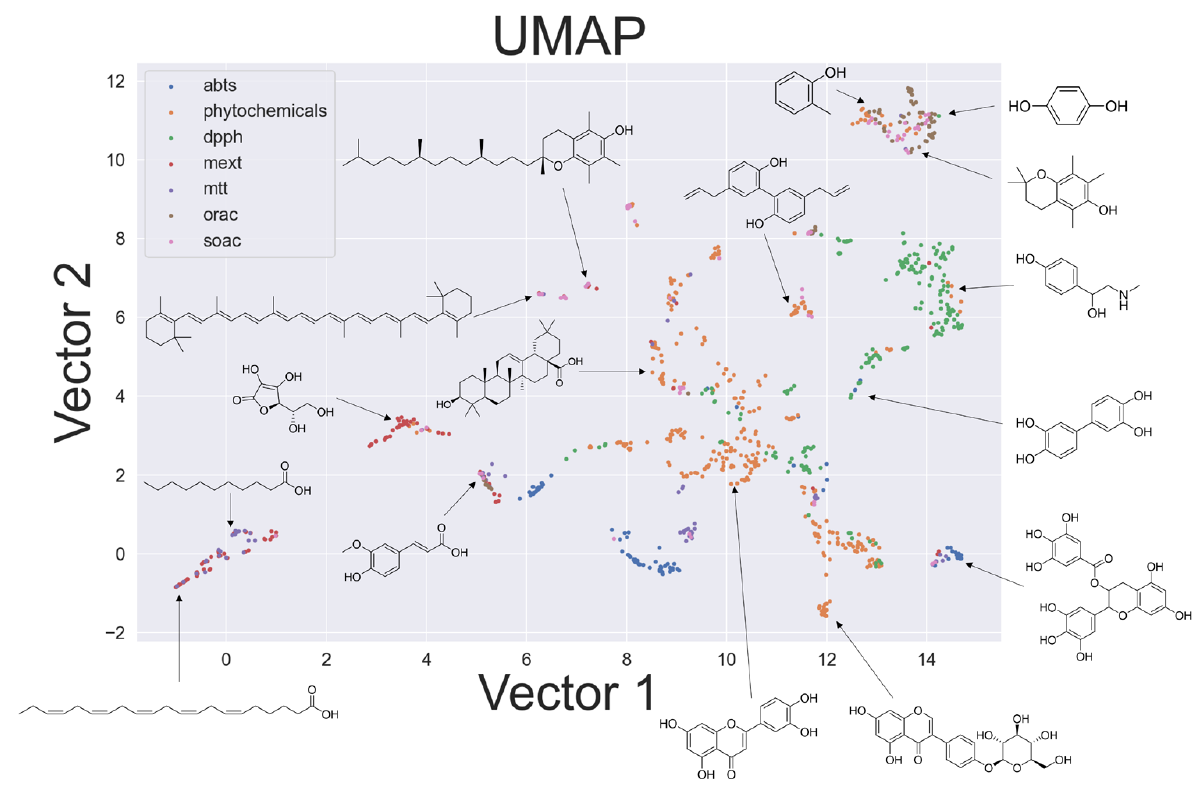
Figure 4. Distribution of compounds related to antioxidant capacity and assay produced by UMAP.